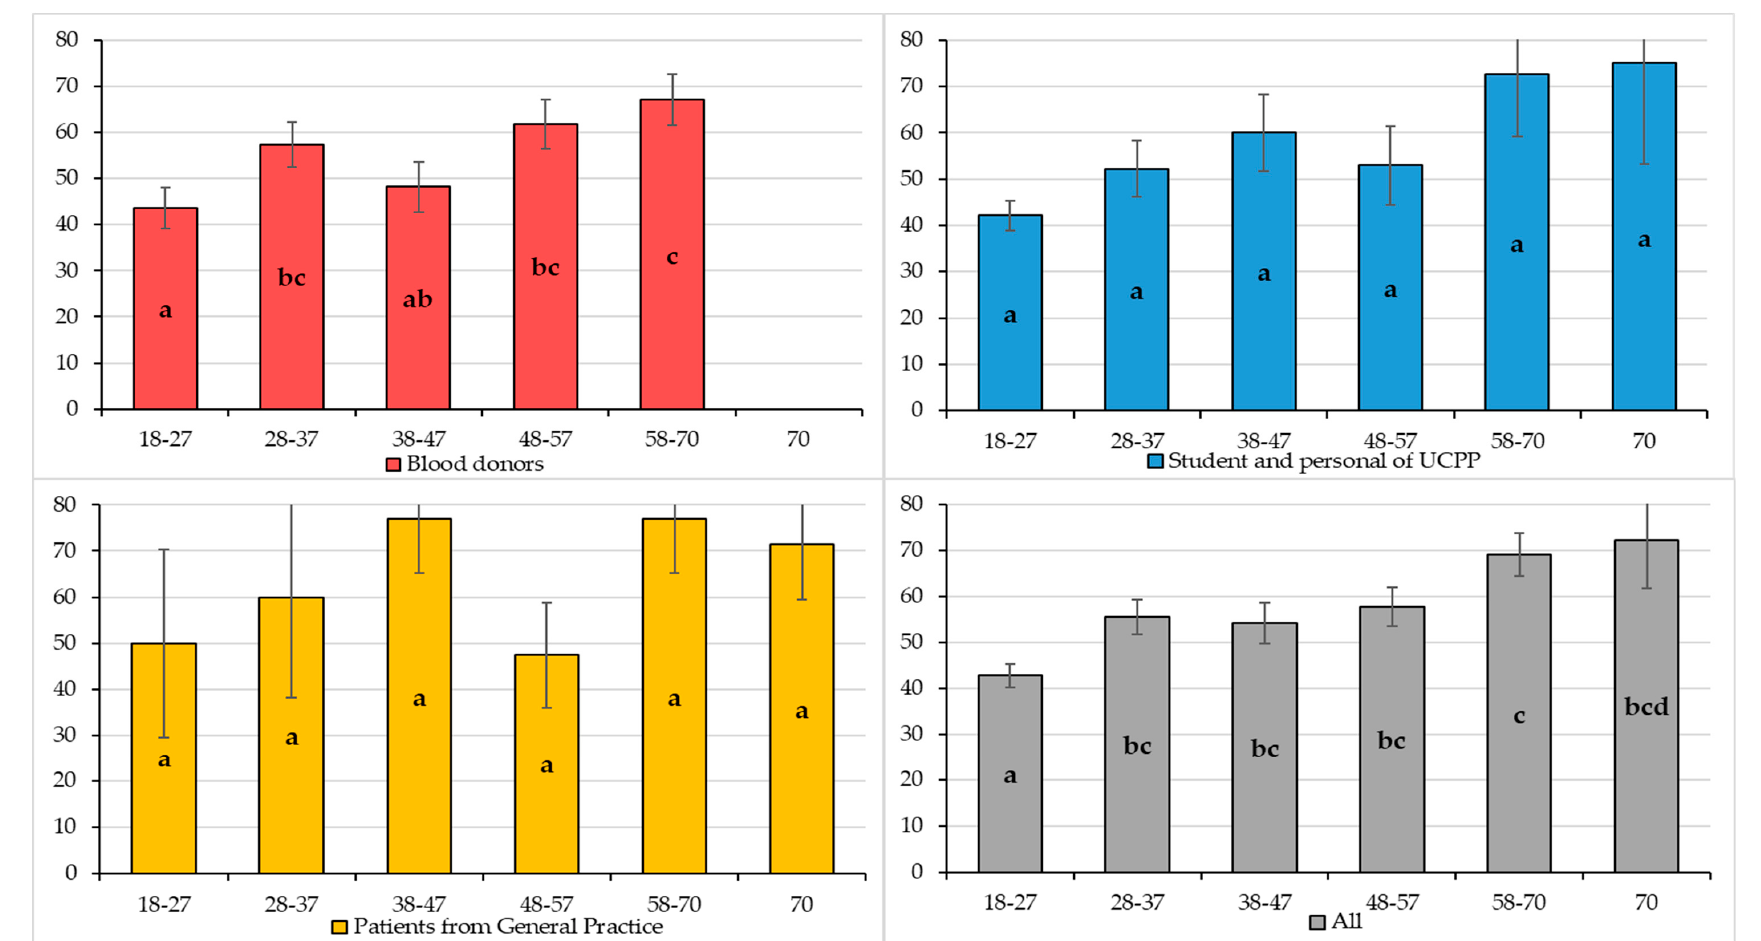
Figure 2. Graphs of the different seroprevalences of anti ‐ HEV IgG (%) by age group and populations. The different lowercase letter (a, b, c, and d) indicates a significant difference ( p < 0.05) between age groups of a given population. For example: among blood donors, the group 18–27 is significantly different from that of 58–70 (“a” vs. “c”), but not from that of 38–47 (presence of the letter a). The black bars correspond to the standard deviation of each proportion.